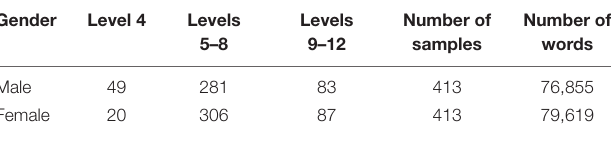
TABLE 1 | Summary of the CELPIP-General corpus of written samples by three writing proficiency bands.